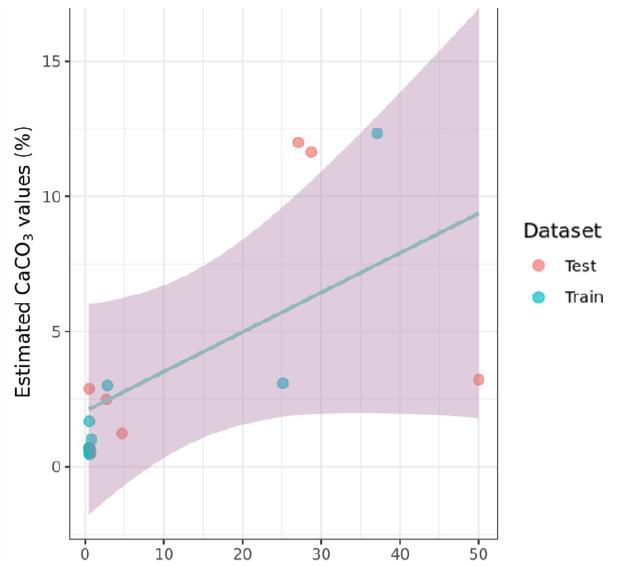
Figure 20. Scatter plot of the best fitted model (PLSR, reflectance) for the CaCO 3 prediction using PRISMA data, including the regression line (blue) with the 95% confidence interval (grey).